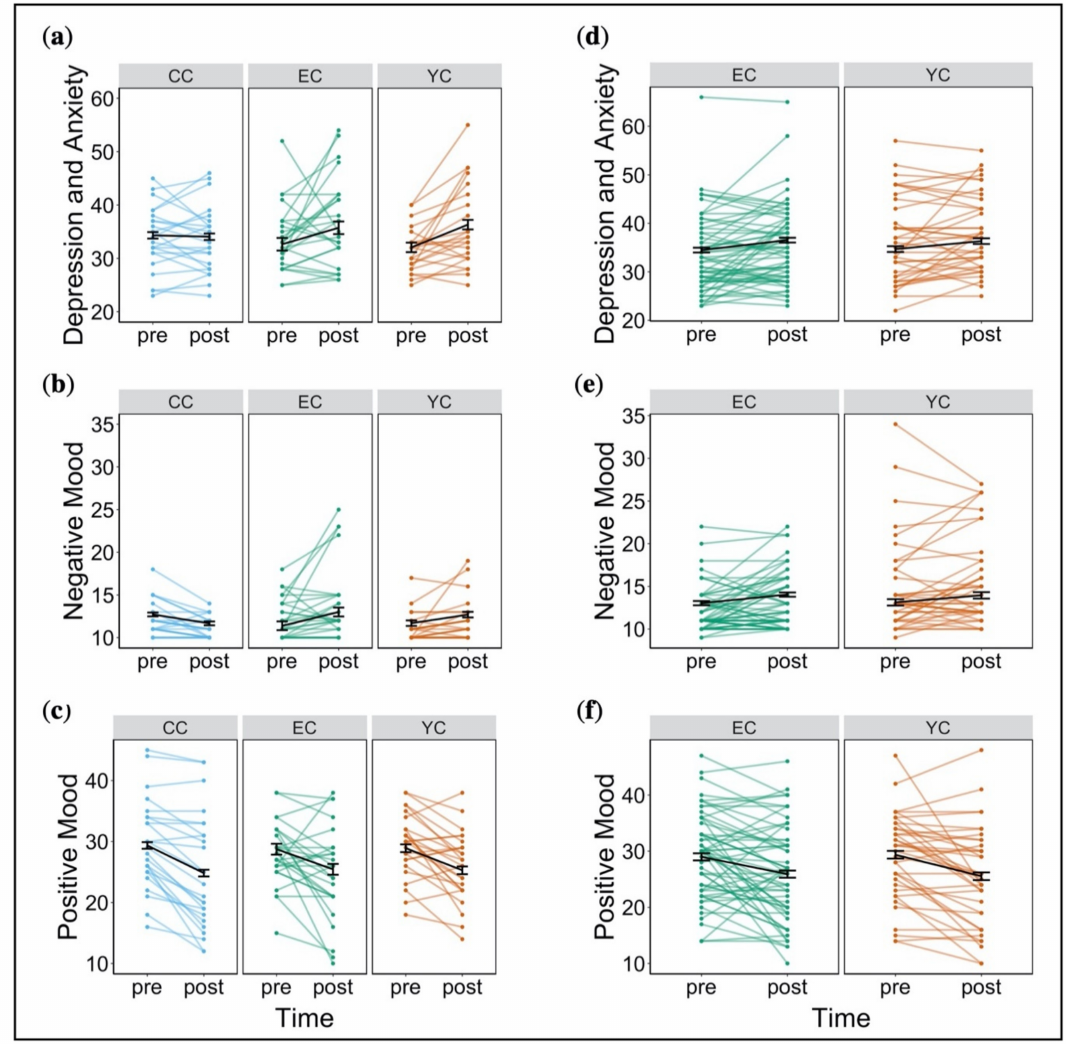
Figure 2. Changes in a ff ective state from pre to post stress induction in study 1 and study 2. ( a ) Depressive symptoms and anxiety in study 1. ( b ) Negative mood in study 1. ( c ) Positive mood in study 1. ( d ) Depressive symptoms and anxiety in study 2. ( e ) Negative mood in study 2. ( f ) Positive mood in study 2. Error bars denote standard error (* p < 0.05, ** p < 0.01, *** p <